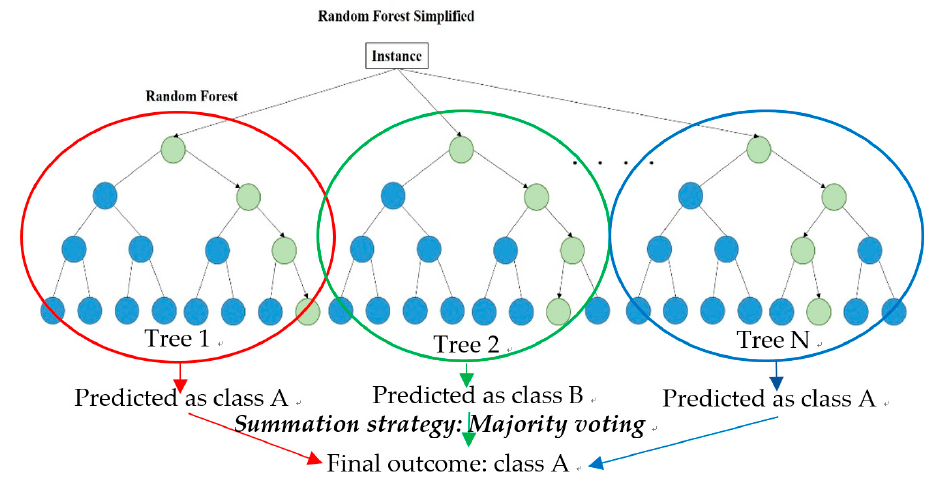
Figure 3. Random forest structure diagram